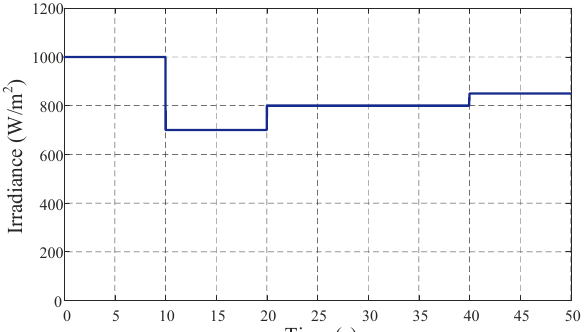
Figure 16. Irradiance